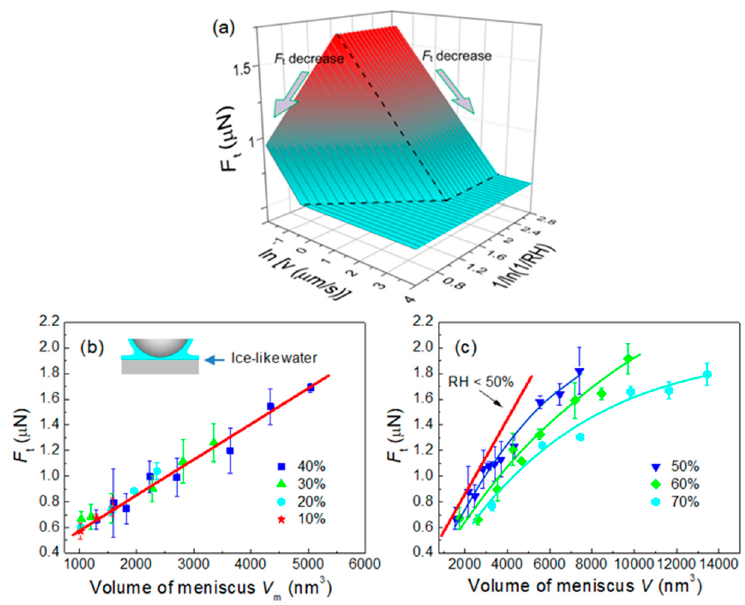
Figure 22 in the main text was misprinted in the published version. The correct figure should be: